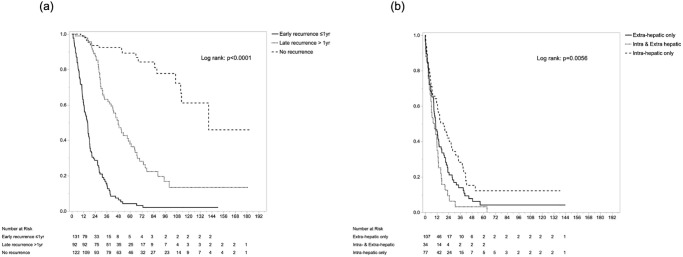
Overall survival after primary resection, stratified by recurrence timing (a) and recurrence pattern (b).